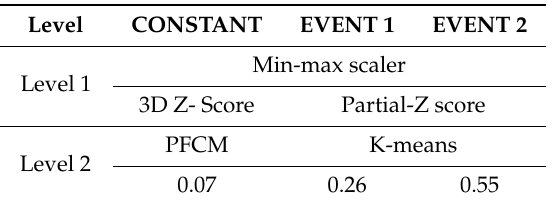
Table 2. Level 1: Analysis process of normalization (min–max scaler) and outlier elimination